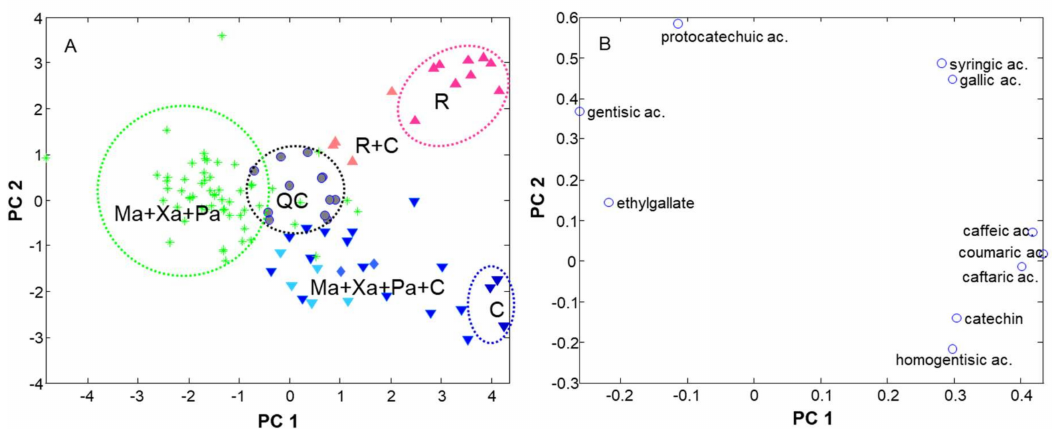
Figure 4. Principal component analysis of the dataset consisting of polyphenol concentrations of each cava sample. ( A ) Plot of scores of PC1 versus PC2; ( B ) plot of loadings of PC1 versus PC2. Acronyms: C Chardonnay; Ma Macabeu; Pa Parellada; Xa Xarel · lo; QC Quality control; R ros é . Symbols: Star = classical coupage (Ma + Xa + Pa); Triangle (vertex up) = ros é cava; Triangle (vertex down) = Chardonnay cava; circle =